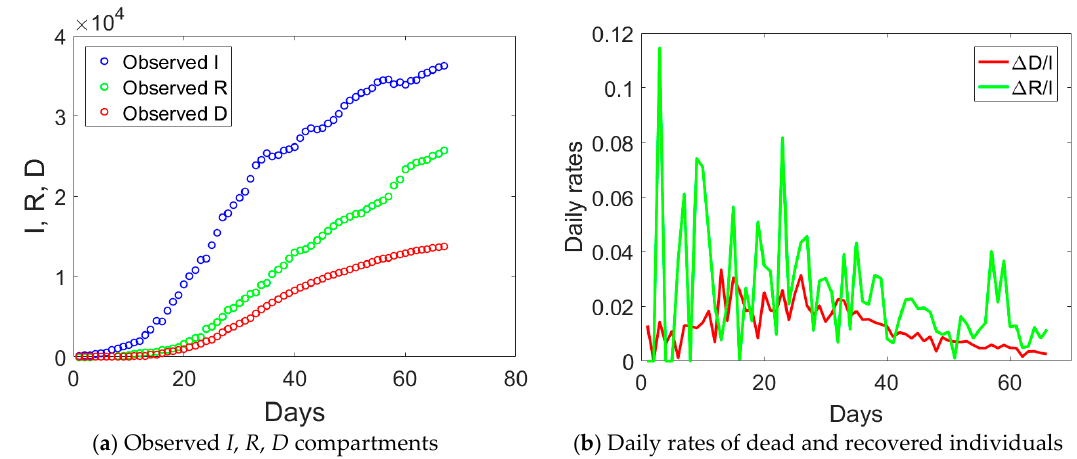
Figure 1. Observed compartments ( a ) and daily rates of dead and recovered individuals ( b )